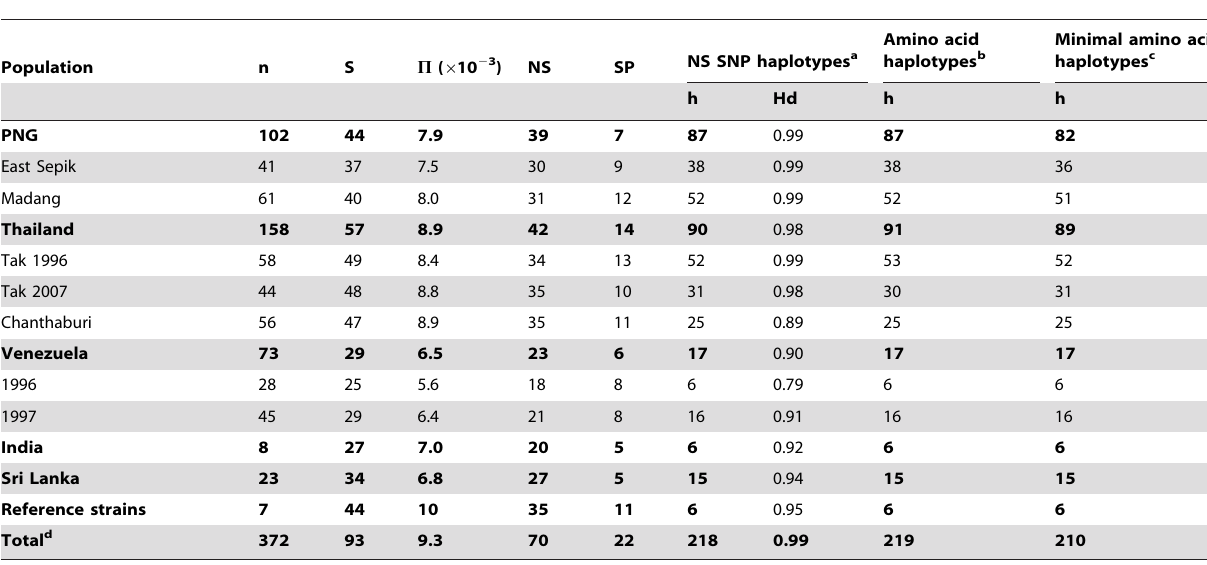
Table 1. Estimates of genetic diversity for Pvama1 in nine worldwide populations.